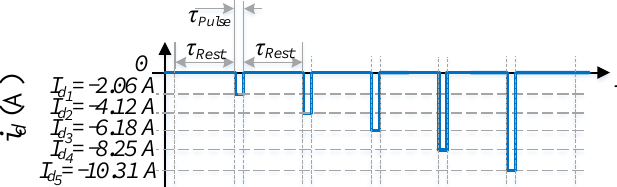
Figure 5. Schematic representation of the string current i d with the five consecutive discharge pulses to estimate the average values of R 0 .